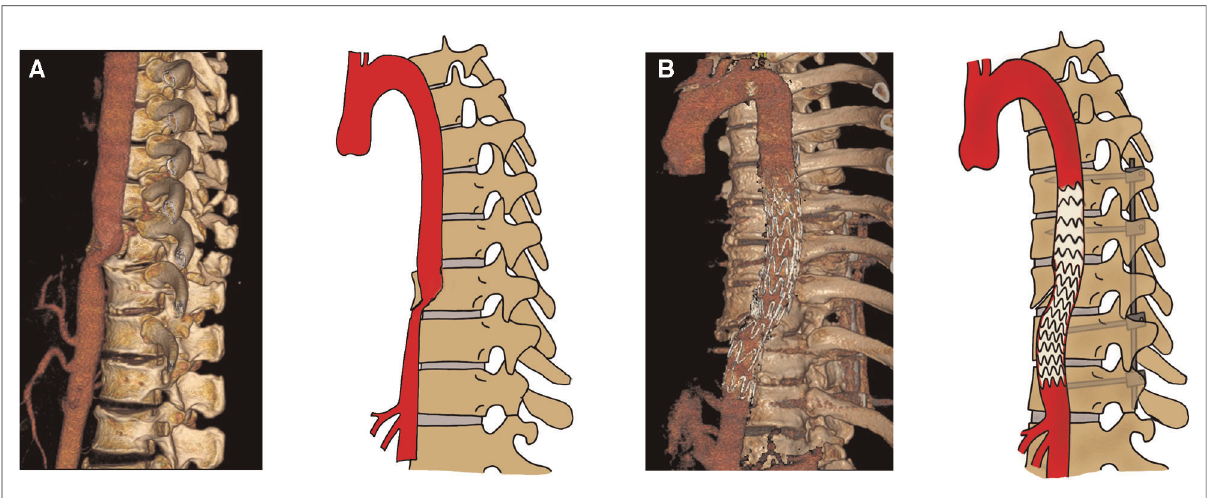
FIGURE 1 Computed tomography angiograms obtained before ( A ) and after ( B ) endovascular repair of the thoracic aortic injury and fi xation of the spinal